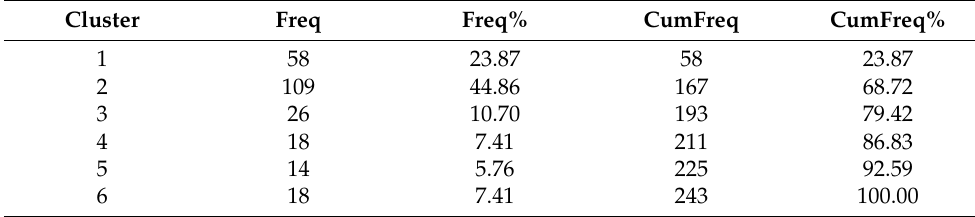
Table 2. Frequency distribution of cluster